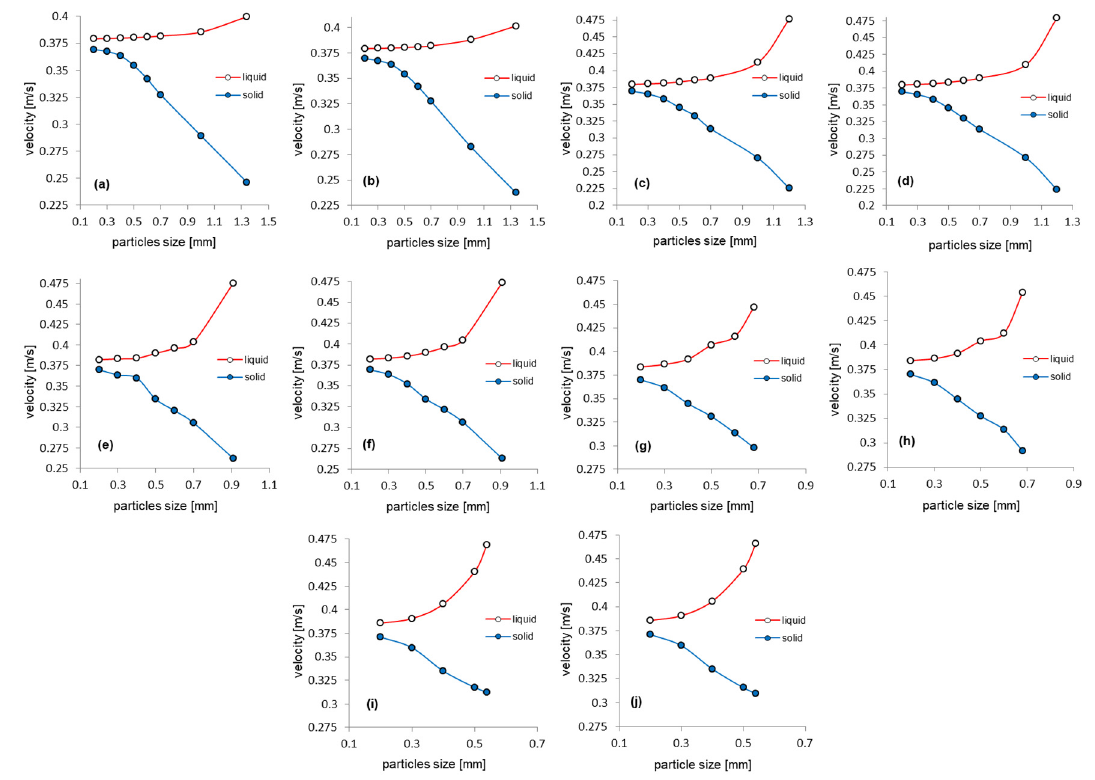
Figure 13. Maximum velocities of the liquid and solids depending on the solid particles size: ( a ) case #1.1; ( b ) case #1.5; ( c ) case #2.1; ( d ) case #2.5; ( e ) case #3.1; ( f ) case #3.5; ( g ) case #4.1; ( h ) case #4.5; ( i ) case #5.1; ( j ) case #5.5.